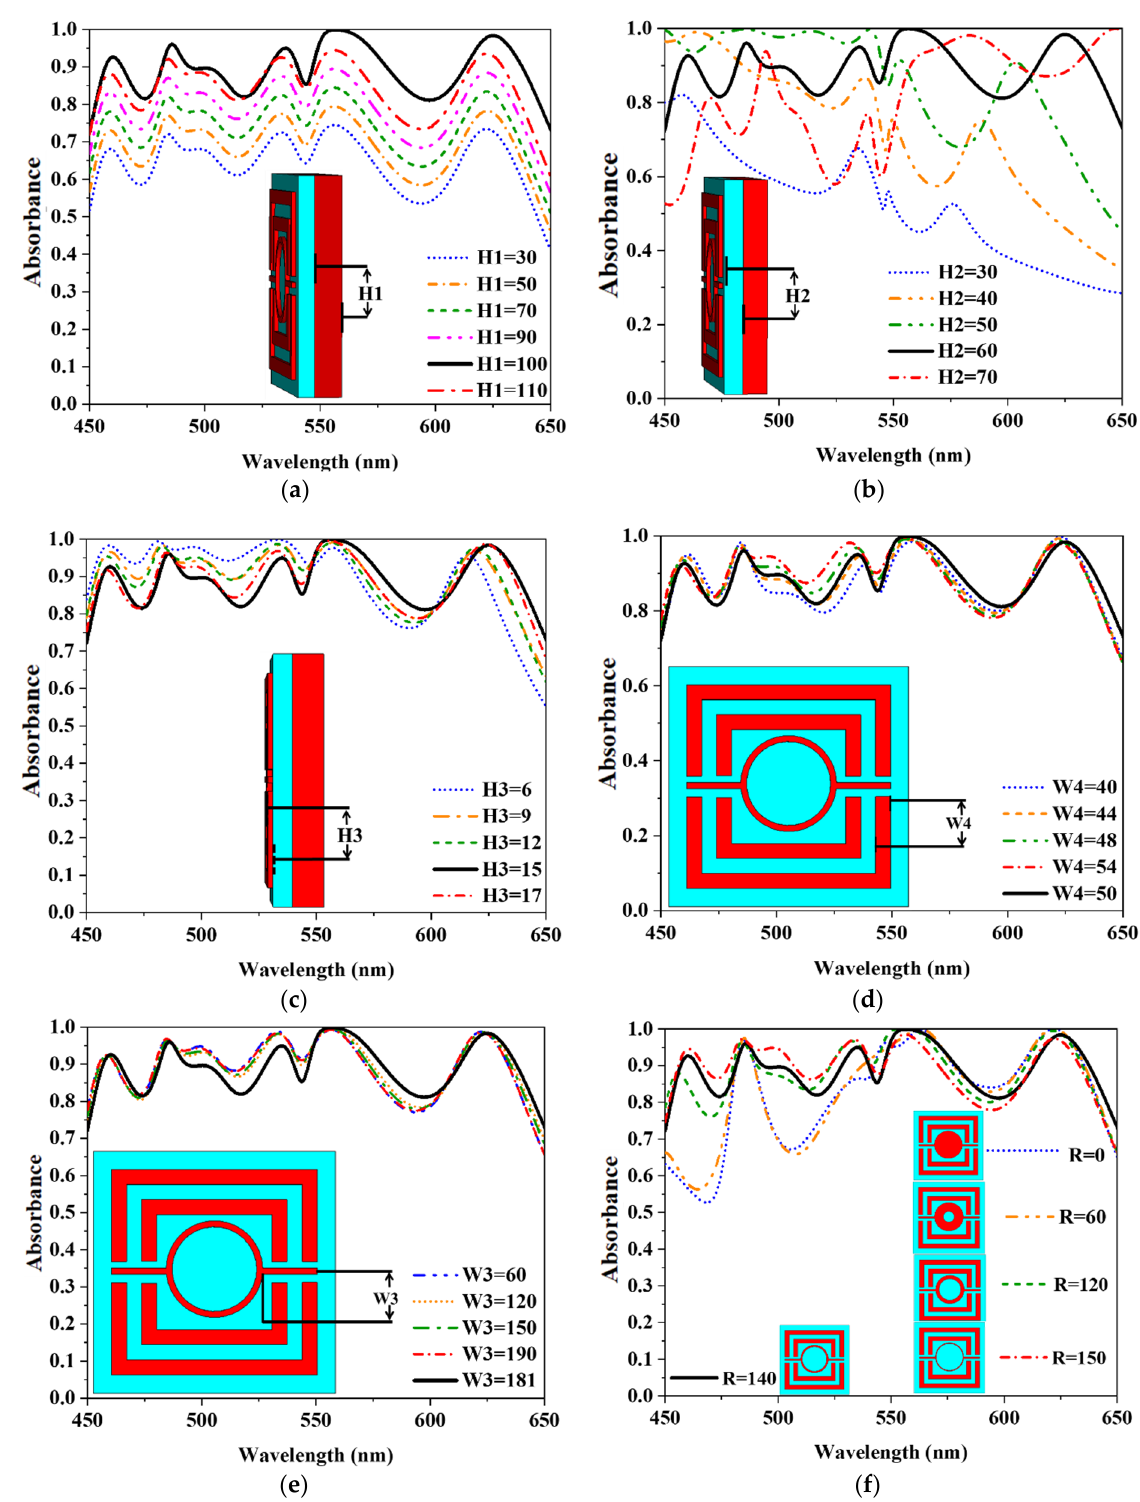
Figure 8. Parametric analysis of ( a ) the bottom tungsten layer thickness, ( b ) SiO 2 dielectric layer thickness, ( c ) resonating patch of tungsten layer thickness, ( d ) resonating patch’s wide ( e ) effect of the circle leg ( f ) effect of the circle radius.